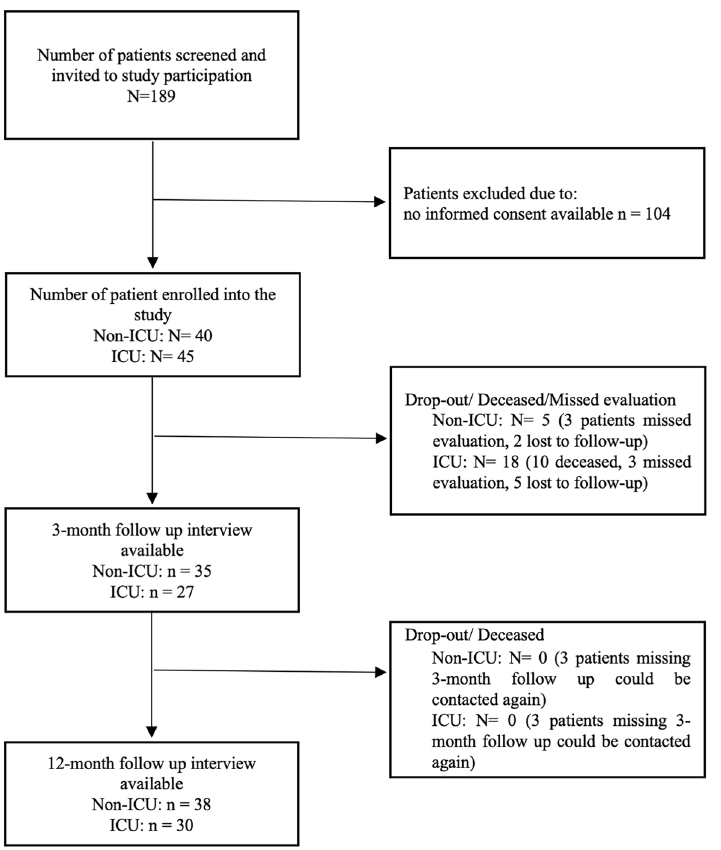
Figure 1. Screening and follow-up. Patients with COVID-19 treated at the University hospital of Würzburg were prospectively screened for study inclusion upon admission. After written consent, baseline characteristics were obtained and follow-up telephone interviews were conducted after 3- and 12-months,